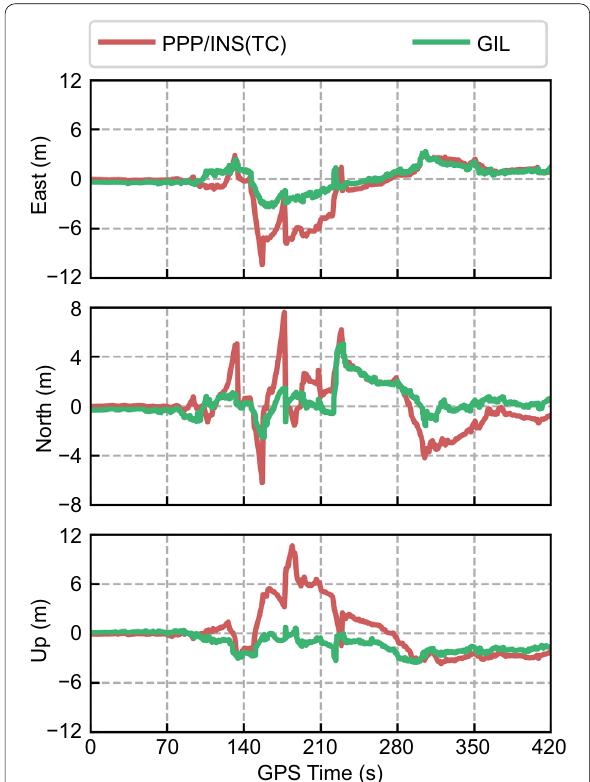
GNSS difficult experiment